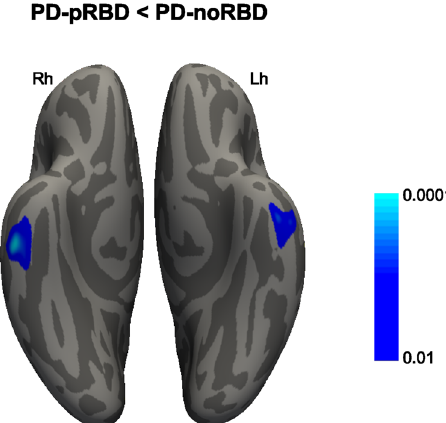
Fig. 1 Cross-sectional cortical thickness differences. PD patients with probable RBD (PD-pRBD) revealed a signi fi cant thinner cortex in the bilateral inferior temporal cortex compared with the PD patients without RBD (PD-noRBD). The color scale bar shows the p -values. Lh, left hemisphere; Rh, right hemisphere.